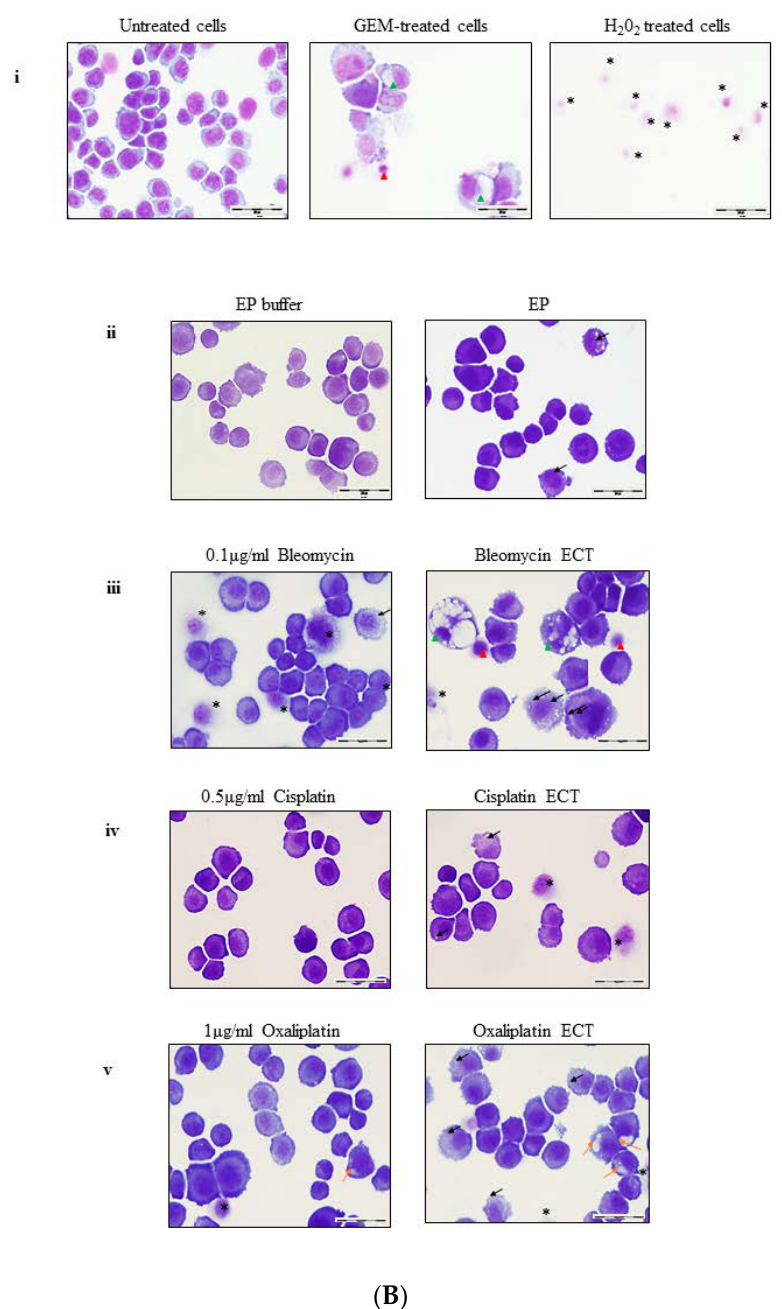
Figure 2. ECT of PANC-1 or Pan02 cells leads to an altered, necrotic-like morphology relative to passive chemotherapy. Morphology of PANC-1 cells ( A ) or Pan02 cells ( B ) either (i) untreated or 72 h post treatment with 100 μ M Gemcitabine (GEM), or 0.2% Hydrogen Peroxide (H 2 O 2 ), (ii) 24 h following treatment in electroporation buffer alone and electroporated, (iii) in Bleomycin and Bleomycin ECT; (iv) Cisplatin and Cisplatin ECT and (v) Oxaliplatin and Oxaliplatin ECT. PANC-1 cells were treated with 0.1 μ g/mL Bleomycin, 0.1 μ g/mL Cisplatin or 3 μ g/mL Oxaliplatin whereas Pan02 cells were treated with 0.1 μ g/mL Bleomycin, 0.5 μ g/mL Cisplatin or 1 μ g/mL Oxaliplatin. Cells were harvested, cytospun and stained for morphological evaluation using light microscopy. Symbols denote particular cellular characteristics: (cid:78) = condensed nuclear material, (cid:78) = decondensed chromatin, → cytoplasmic vesicles, → perinuclear vacuoles, (cid:78) = large vacuoles, * = translucent cytoplasm. Scale bar = 20 µ